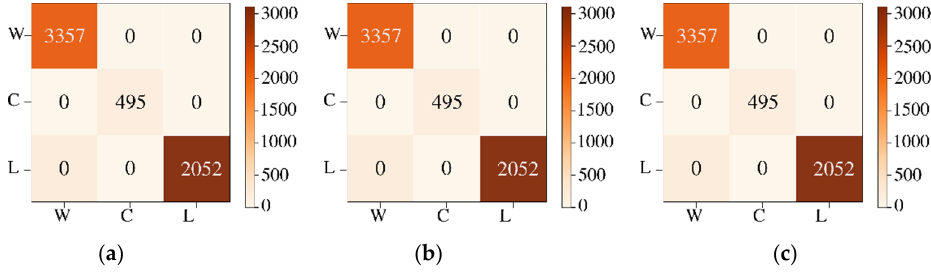
( b ) Figure 9. ( a ) HSI2 Image 1 with labels for 3 classes using the unsupervised stage (k-means clustering method), ( b ) Reconstructed image from classified samples using the supervised stage. Figure 10 shows the confusion matrices for the reconstruction of HSI2 Image 1 using 3 PCA bands with the three types of scaling methods. All of the scaling methods give 100% accuracy using GB classifier, and second best classifier is GC.